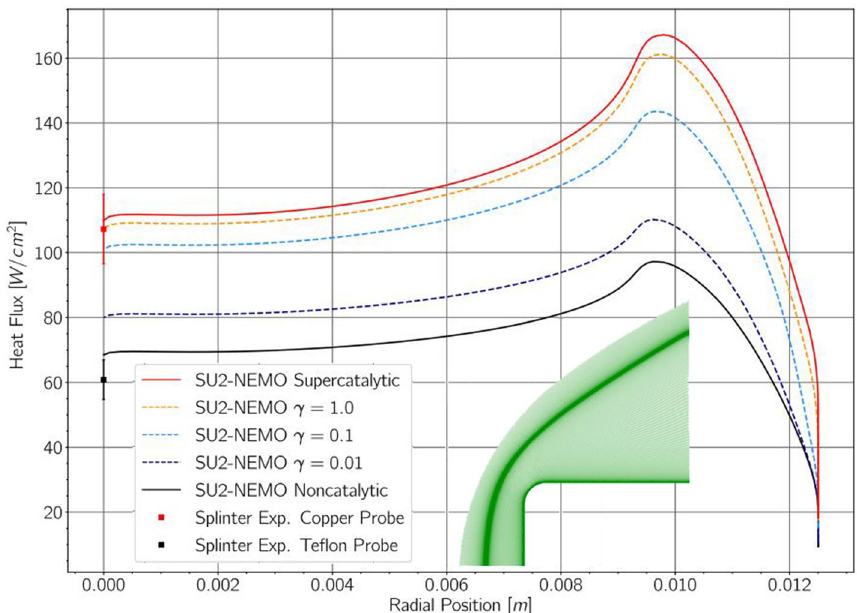
Fig. 16 Heat flux on a calorimeter probe [133]